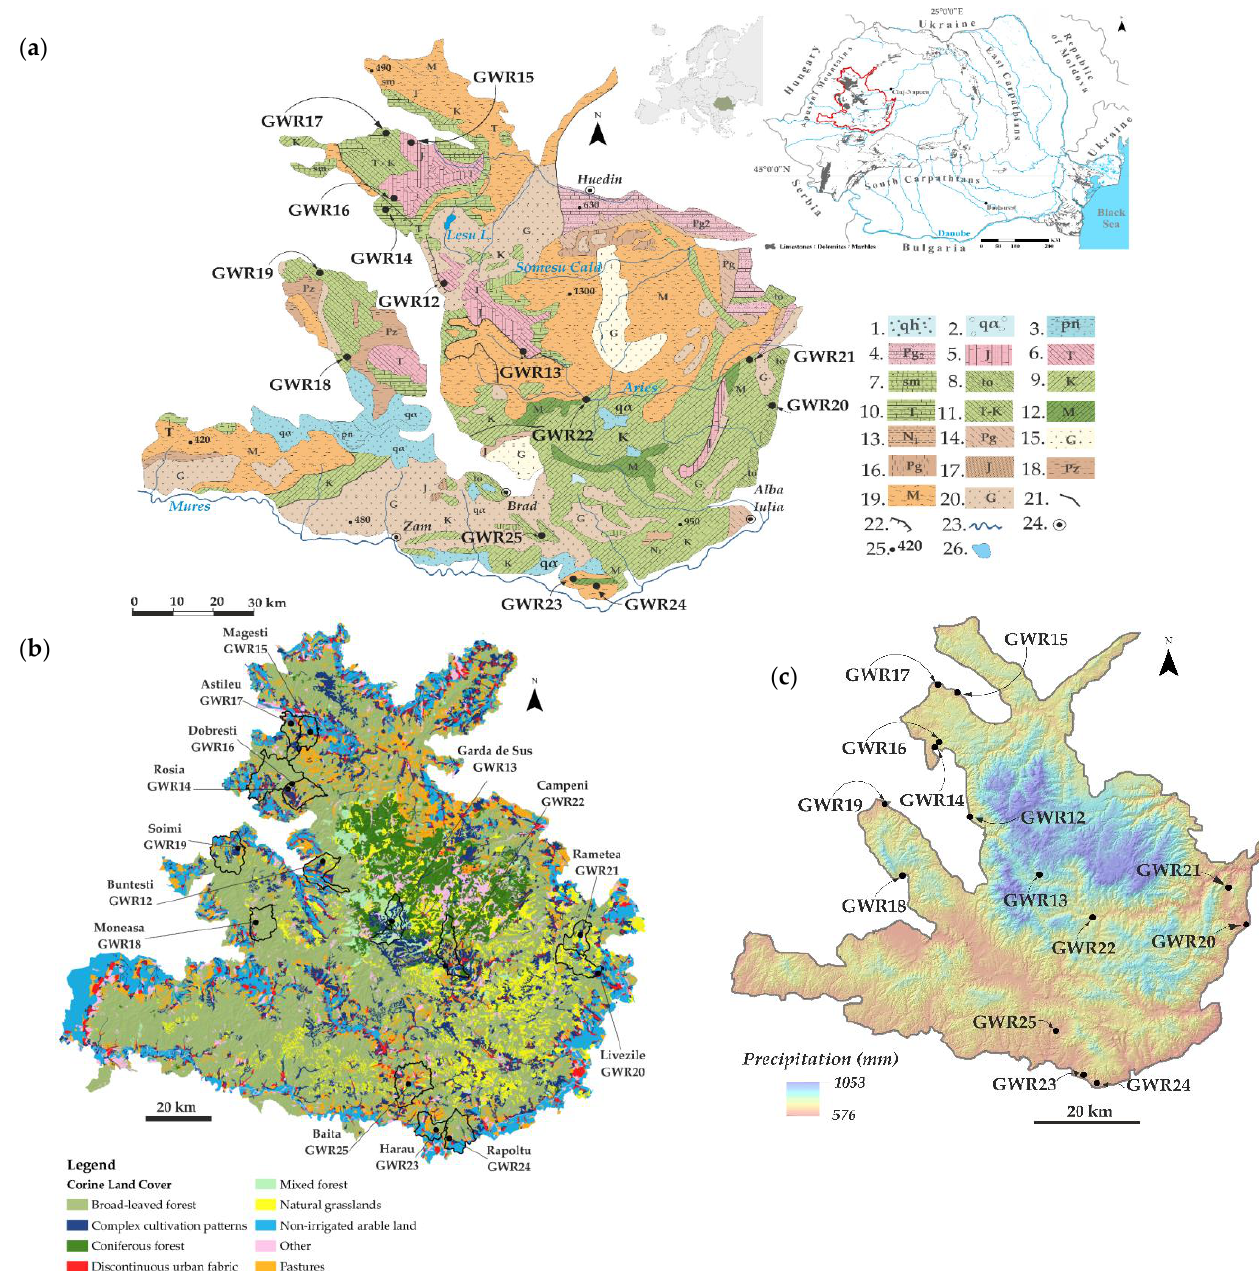
Figure 1. Sampling sites ’ locations in the general groundwater map ( a ) (modified after Ghenea et al., 1981 [14]); Corinne Land Cover ( b ) (data from Copernicus Land Monitoring Service 2018, European Environment Agency [15]), and the mean annual precipitation ( c ) (modified after Fick et al., 2017 [16]) in the Apuseni Mountains. Legend for ( a ): 1. Gravels and sands; 2. Pyroclastic rocks; 3. Gravels, sands and clays (local or discontinuous aquifers in porous formations); 4. Limestones and marly limestones; 5. Limestones; 6. Limestones and dolomites (local aquifers in limestones); 7. Limestones, sandstones and conglomerates; 8. Calcareous sandstones and limestones; 9. Limestones, marly limestones, sandstones and conglomerates; 10. Limestones and sandstones; 11. Limestones, dolomites, sandstones and conglomerates; 12. Limestones and dolomites in metamorphic formations (local or discontinuous aquifers in fissured rocks); 13. Marls, clays, tuffs and sands; 14. Marls, clays, limestones, sands and conglomerates; 15. Igneous rocks (formations with possible deep aquifers); 16. Red clays and marls; 17. Marls and shales; 18. Shales, clays, sandstones and conglomerates; 19. Crystalline schists; 20. Igneous rocks (formations without groundwater); 21. Faults; 22. Overthrust; 23. Rivers; 24. Localities; 25. Altitude (m); 26. Lakes.